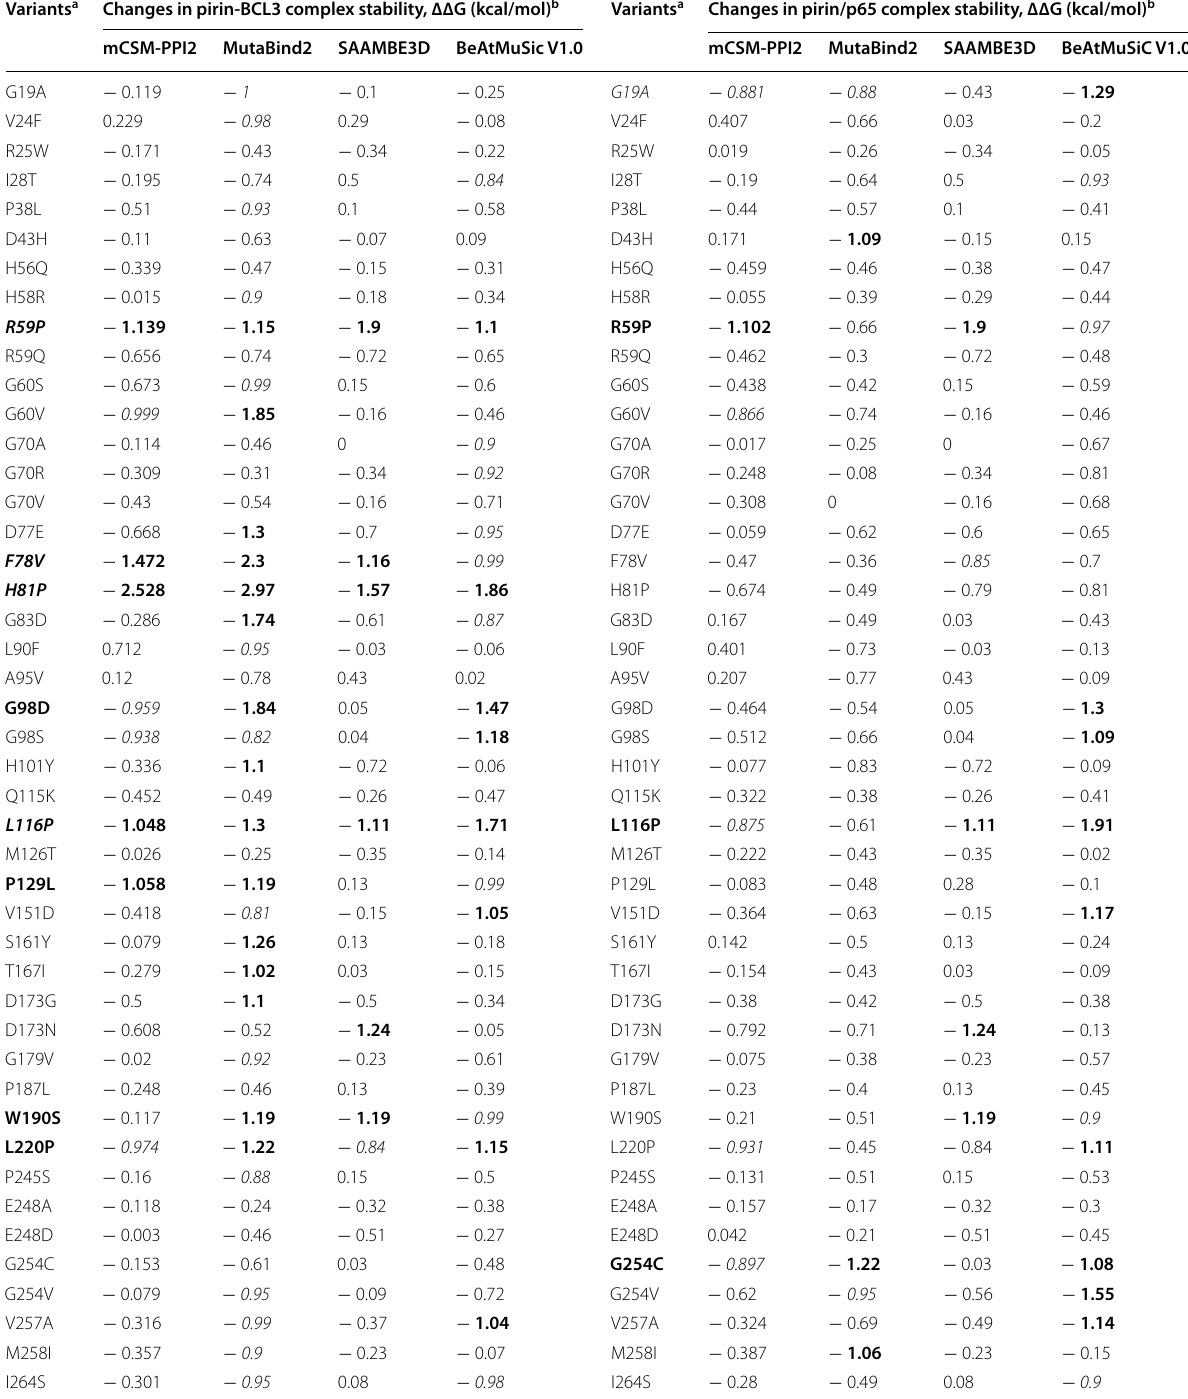
Table 4 Effects of potentially pathogenic missense variants on stability of pirin-BCL3 and pirin-p65